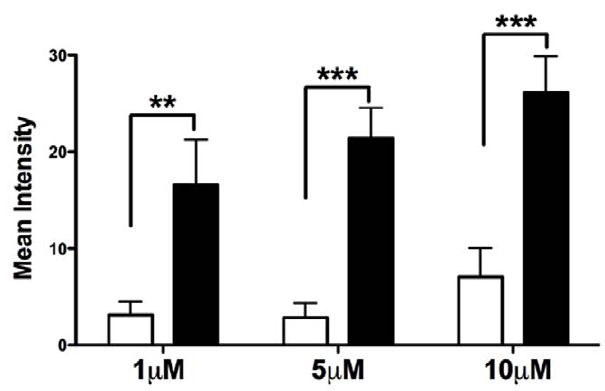
Figure 4. CSE exposure promotes adherence of intact P. gingivalis to rGAPDH. P. gingivalis adherence to immobilized rGAPDH was assessed by dot blot. 10 9 cfu/ml of P. gingivalis , grown either in GAM or CSE, were added to each blot and adherent bacteria detected using anti- P. gingivalis IgG. Averaged mean intensities from three independent blots indicate CSE exposure augments binding to GAPDH